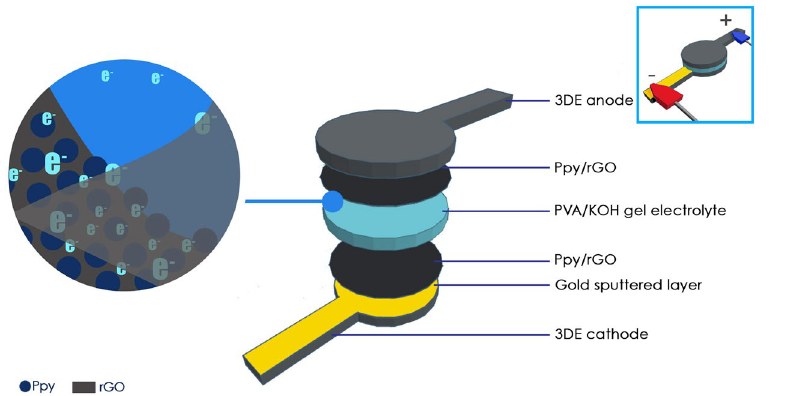
Figure 3. Schematic illustration of solid-state supercapacitor